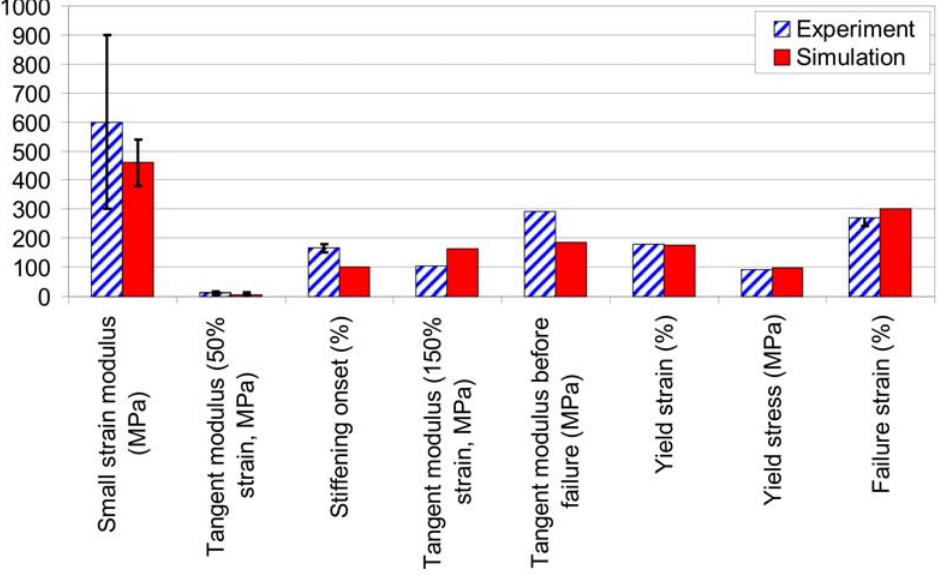
Figure 5. Comparison of mechanical properties of IF filaments between experiment and simulation (based on data shown in Table S2).